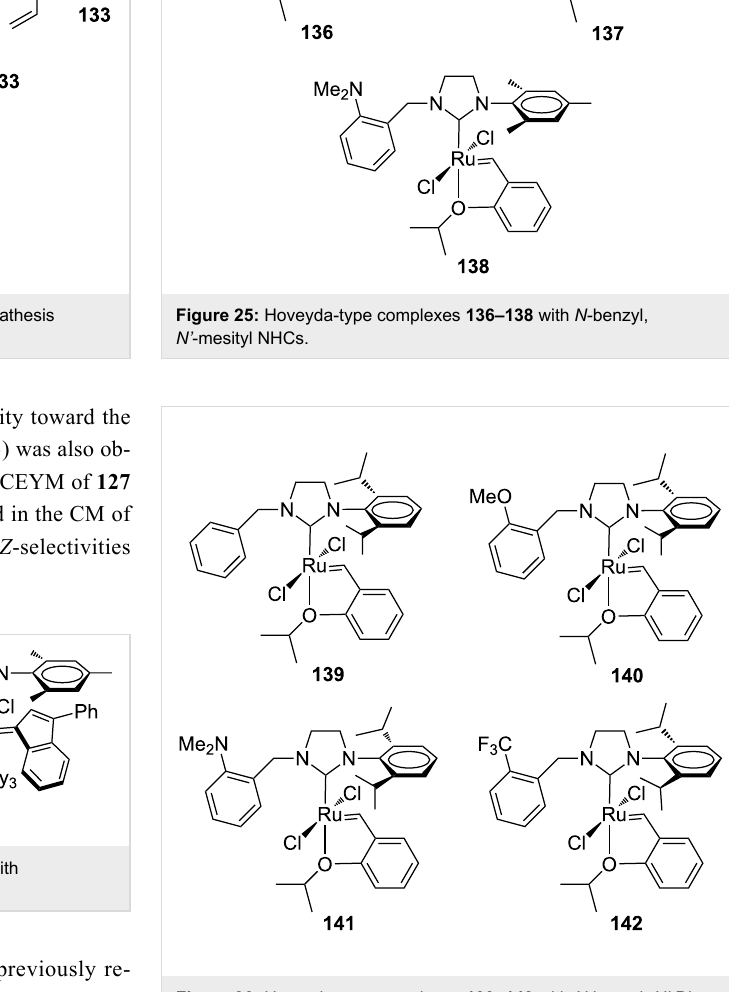
Figure 26: Hoveyda-type complexes 139 – 142 with N -benzyl, N’ -Dipp NHC. Catalysts 136 – 142 were tested in the RCEYM of 127 , in the RCM of 129 and in the CM of 13 and 14 (Table 5, entry 3). Ac- cording to the experimental results, mesityl-bearing catalysts generally gave better yields than Dipp-containing analogues. In the presence of 136 – 138 , a high selectivity in the dRRM of cyclopentene 131 was also observed (Scheme 12). Self metathe- sis of 1-octene ( 96 ) was conducted in the presence of 136 , 137 , 139 and 140 , in order to selectively obtain tetradec-7-ene ( 97 ). The presence of the N -benzyl substituent was crucial to achieve high yield (up to 80%) of the desired product, whereas commer- cial HGII-SIMes and HGII-SIPr , despite the higher reaction rate, gave mainly a mixture of